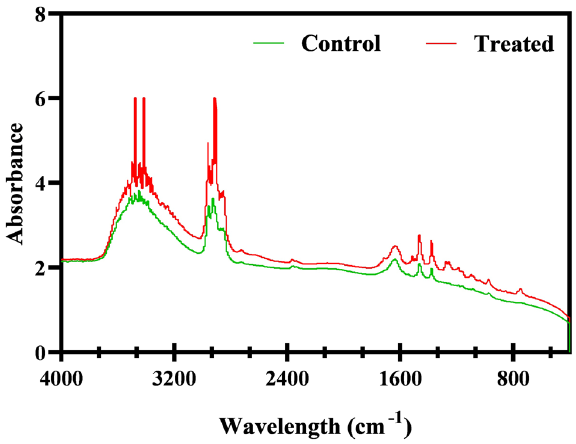
Figure 13. FTIR analysis of C. albicans farnesol upon 24 h treatment with catechol (at 256 µg/mL).